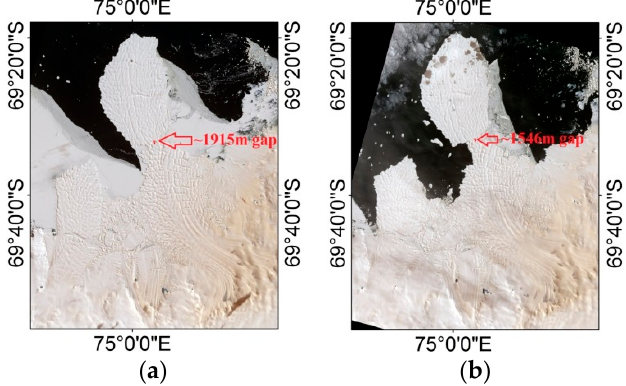
Figure 14. Gaps between the PRG and the frontal iceberg in 2005 and 2006. ( a ) February 2005; ( b ) February 2006.